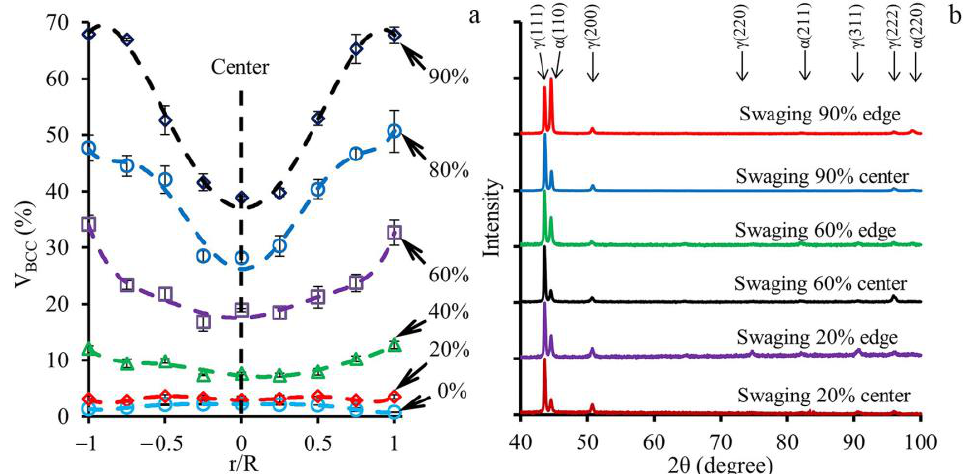
Figure 3. ( a ) Distribution of the ferromagnetic BCC-phase volume fraction (V BCC ) along the diameter and ( b ) the XRD patterns after different swaging modes.